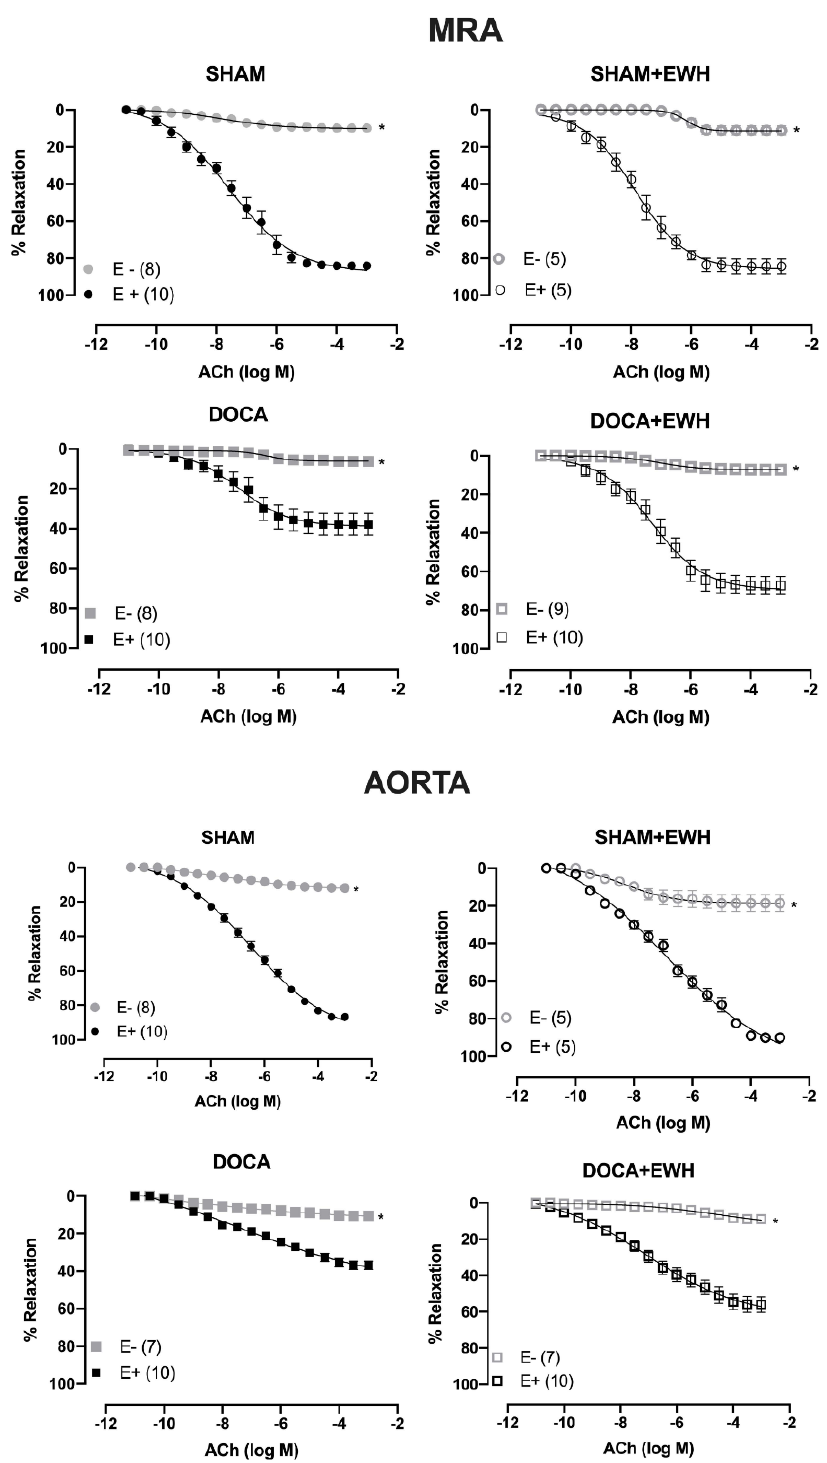
Figure 4. The role of endothelium on the effect of EWH in ACh-induced relaxation of MRA and aorta segments from DOCA-salt rats. Concentration–response curve to ACh in the presence (E+) and absence of endothelium (E − ) in MRA (Upper graphics) and aorta (Bottom graphics) segments from rats SHAM, SHAM+EWH, DOCA, and DOCA+EWH. The results are expressed (mean ± SEM) as the percentage of relaxation responses in norepinephrine or phenylephrine precontracted rings. The number of rats is indicated in parentheses. Two-way ANOVA followed by Bonferroni post-test: p < 0.05 * vs.